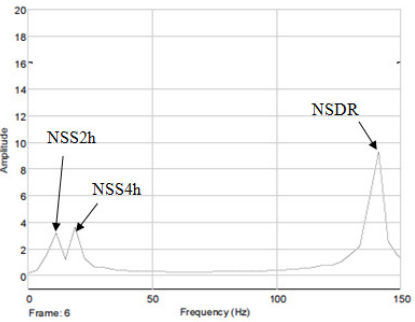
Figure 18. Frequency analysis of position signal prior to NSS filtering.